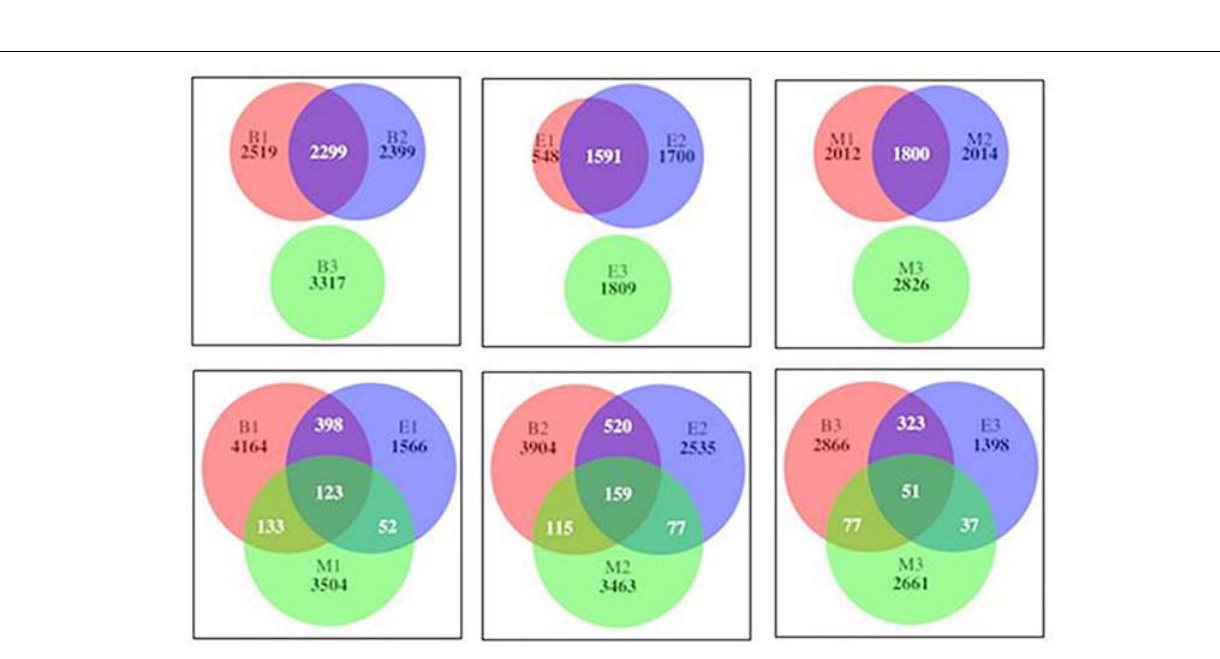
FIGURE 12 | Venn diagram showing number of shared and specific prokaryote ASVs among primers within wetlands (above) and among wetlands of primers (below). The abbreviations and numerics used are as follows: B, Bhomra; E, EKW; M, Malencho; 1, 341b4_F/806_R; 2, N341b4_F/806_R; 3, Pro341F/Pro805R; ASV, amplicon sequence variant; EKW, East Kolkata